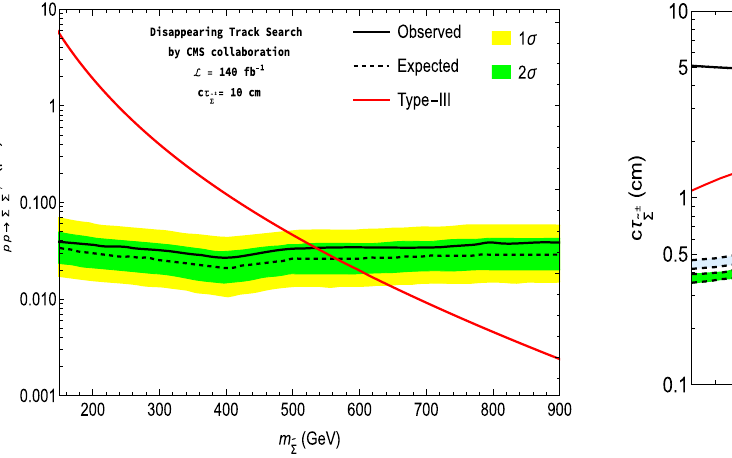
Fig. 11 The left panel shows the CMS bound on the production cross section of ˜ (cid:2) ± with lifetime c τ = 10 cm as a function of its mass m ˜ (cid:2) . The solid (dashed) black horizontal lines are the observed (expected) limits on the cross section while the green (yellow) band are expected 1(2)- σ upper limit on the production cross section. The red diagonal line is our result for the total production cross section of the ˜ (cid:2) ± at